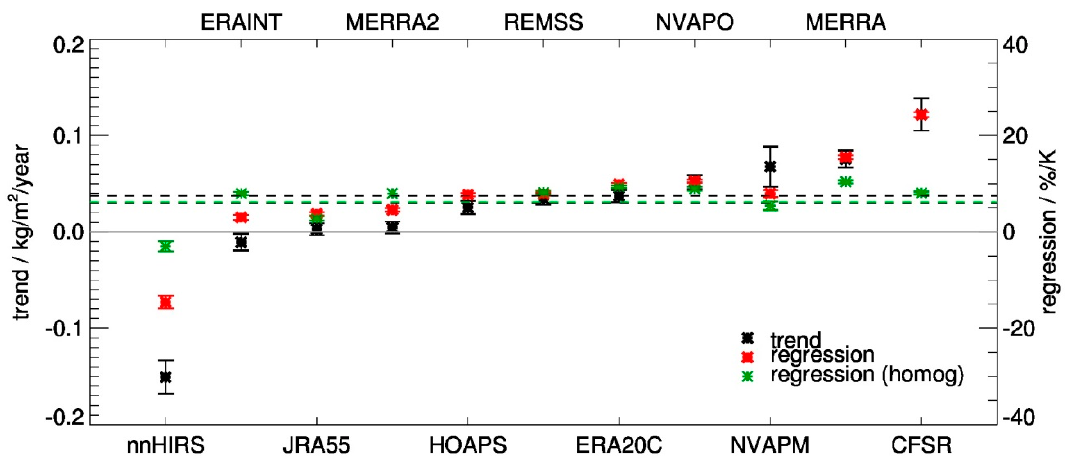
Figure 1. Trend estimates in TCWV in kg/m 2 /year and regression coefficients in %/K for eleven data records. Also shown are regression coefficients which have been computed using homogenised TCWV data records (see text for details). TCWV values have been averaged over the global ice-free ocean within 60 ◦ N/S and cover the common period 1988-2008. The vertical bars show the estimated uncertainty of the trends and the regression coefficients. The black dashed lines mark the typically expected range of regression values given in, e.g., [30], while the green dashed line marks the expectation, computed using observed SST. The light grey line marks the zero line. Recall that the use of the trend analysis is to identify issues in the data records and it is not claimed that these are the trends occurring in nature.